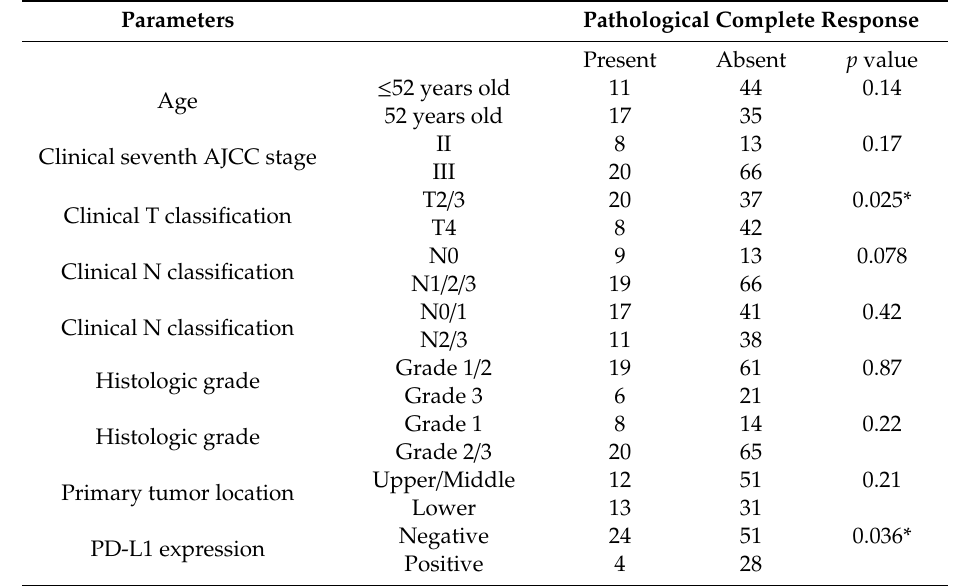
Table 3. Associations between a pathologically complete response and clinicopathologic